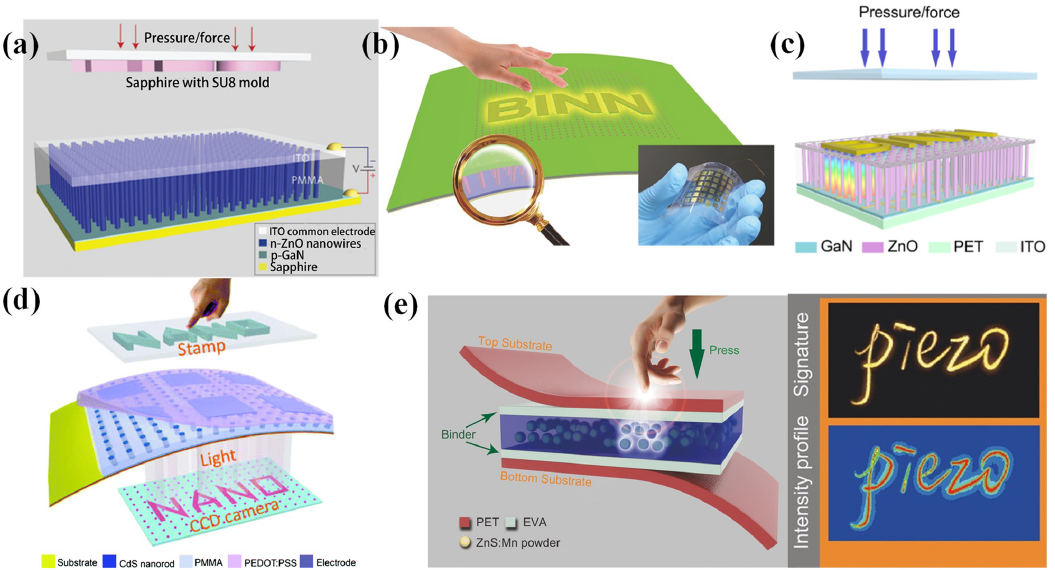
Figure 4. ( a ) High-resolution electroluminescent imaging of pressure distribution using a piezoelectric nanowire LED array. Reproduced with permission from Ref. [82]. Copyright 2013, Nature Publishing Group. ( b ) A flexible and controllable piezo-phototronic pressure-mapping sensor matrix